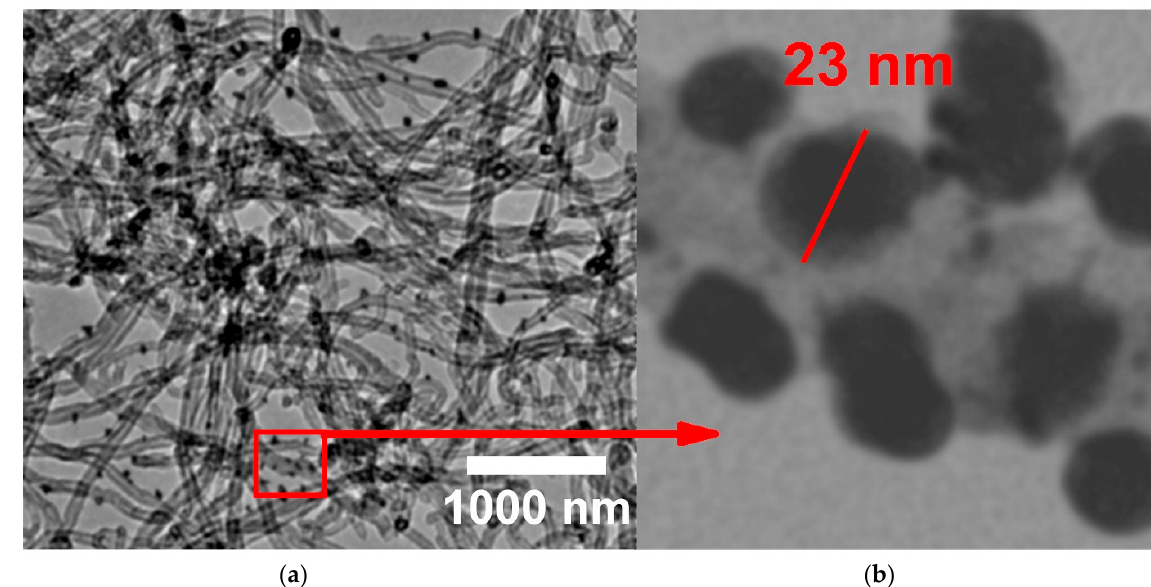
Figure 4. TEM image of the prepared Ag NPs/CNTs (1) nanocomposite formed via pulsed laser ablation of the silver plate for about 10 min ( a ) at low magnification ( b ) high magnification.